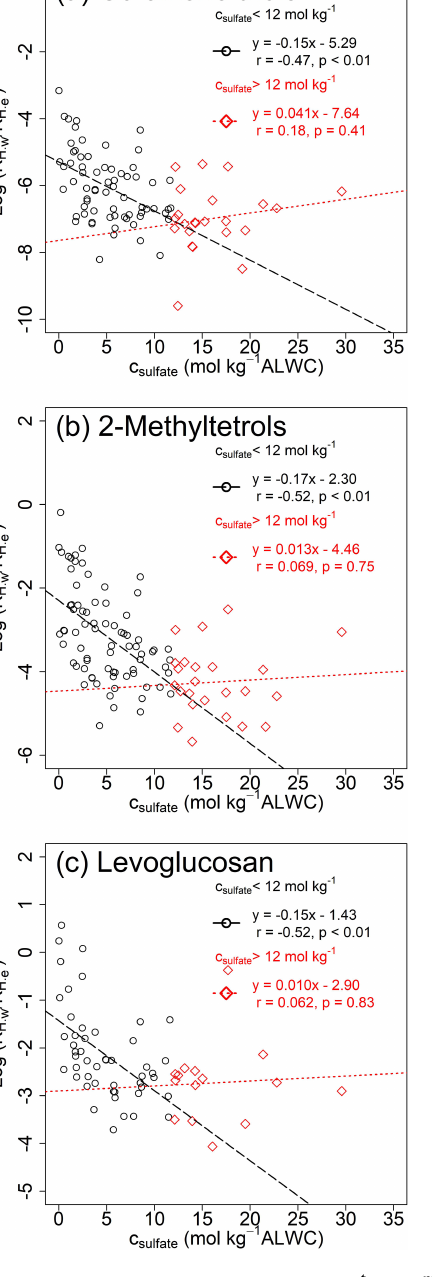
Figure 4. Modified Setschenow plots of log (K t c sulfate for (a) C5-alkene triols, (b) 2-methyltetrols, and (c) levoglu-